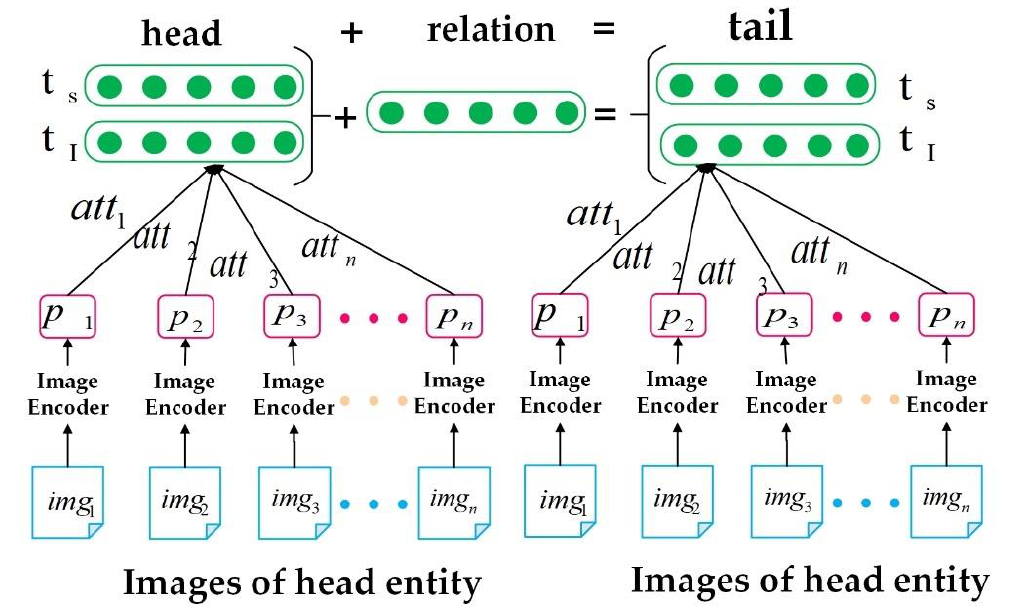
Figure 12. Overall architecture of the IKRL model, which integrates multi-modal information to improve the accuracy of triplet prediction [102]. improve the accuracy of triplet prediction